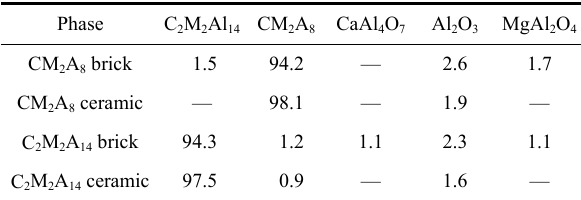
Table 1 Quantitative analysis results of CM 2 A 8 and